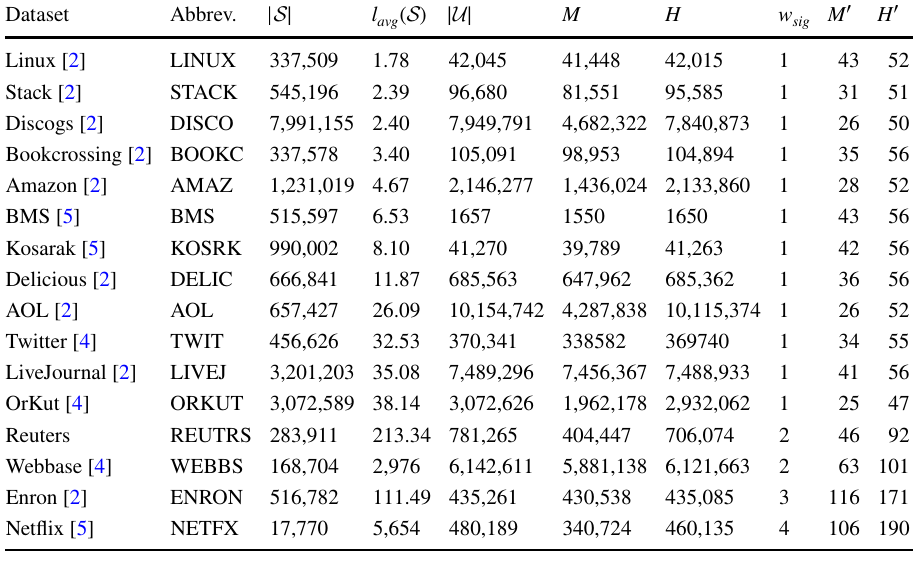
Table 2 Characteristic of real datasets